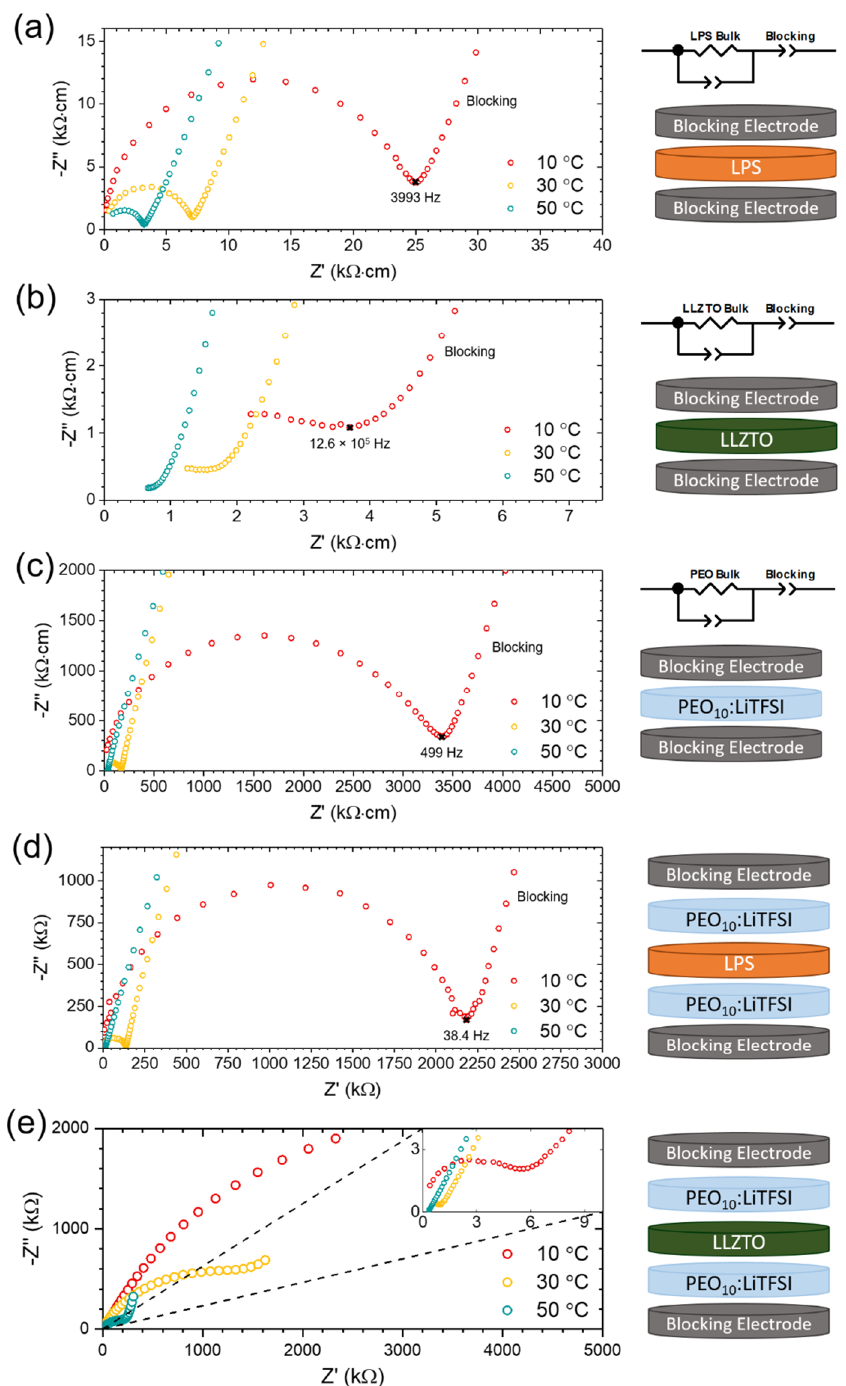
Figure 1. Nyquist plots, equivalent circuit models and schematics corresponding to PEIS of ( a ) LPS electrolyte with blocking electrodes; ( b ) LLZTO electrolyte with blocking electrodes; ( c ) PEO 10 :LiTFSI with blocking electrodes; ( d ) PEO 10 :LiTFSI/LPS/PEO 10 :LiTFSI trilayer with blocking electrodes; and ( e ) PEO 10 :LiTFSI/LLZTO/ PEO 10 :LiTFSI trilayer with blocking electrodes. PEIS was carried out at 10 ◦ C (red), 30 ◦ C (yellow) and 50 ◦ C (green), from an initial frequency of 1